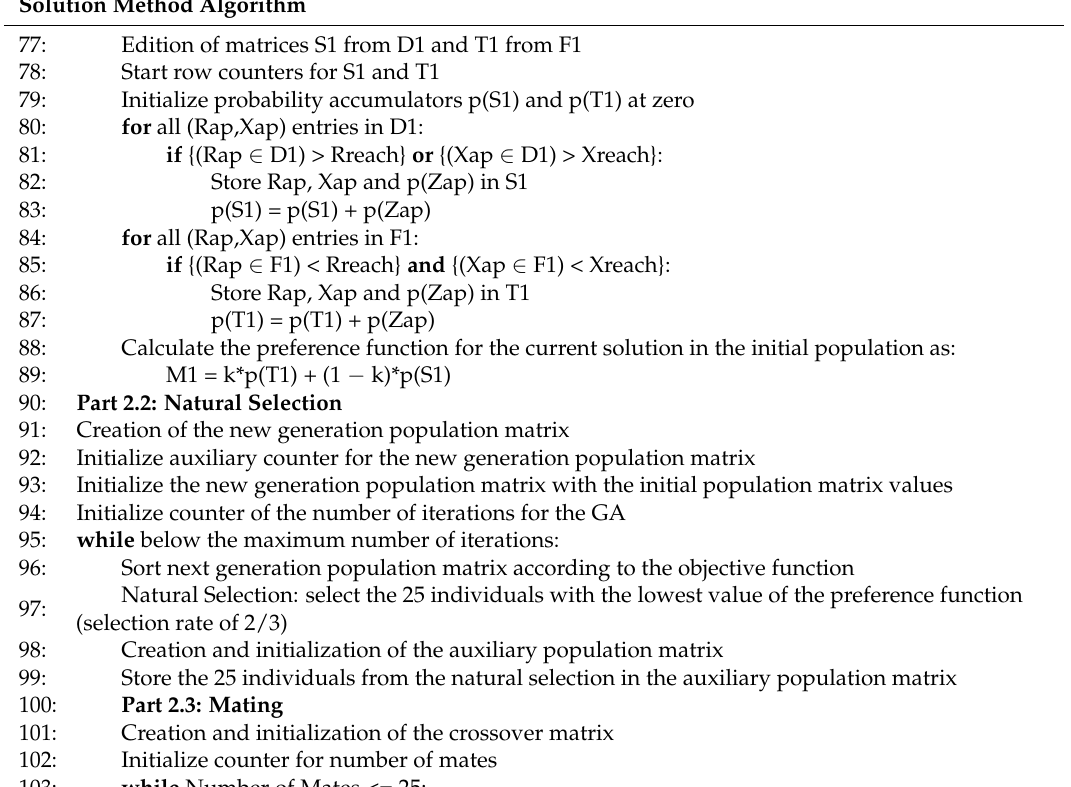
Solution Method